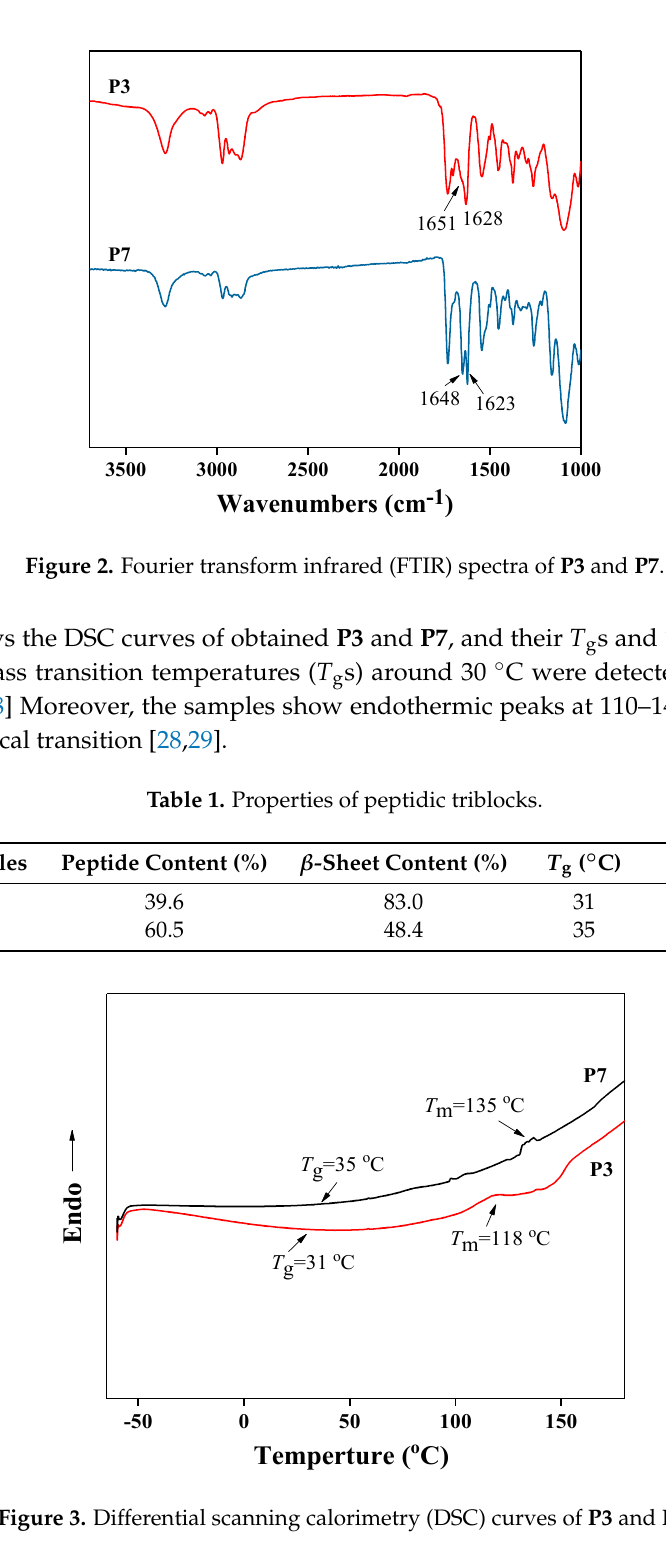
Figure 3. Differential scanning calorimetry (DSC) curves of P3 and P7 .